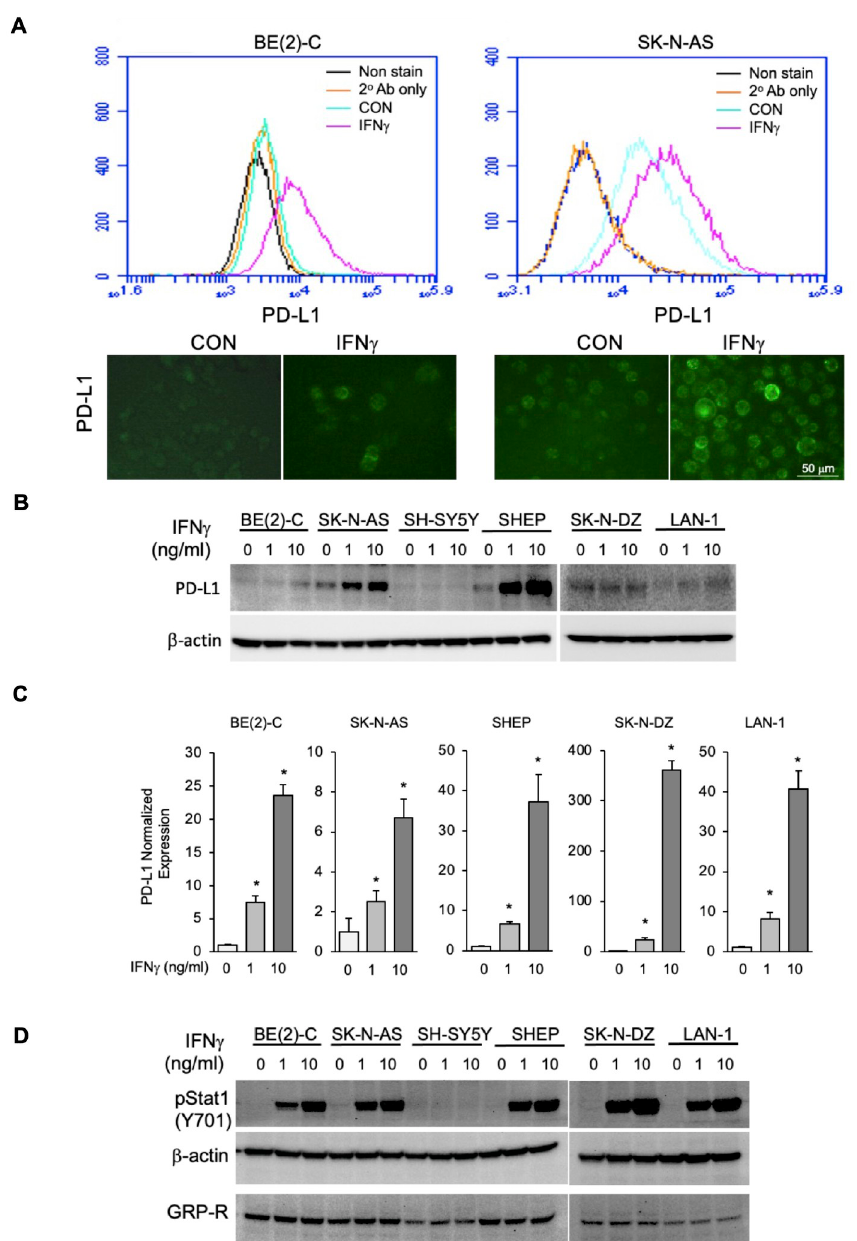
Fig 5. Immune checkpoint protein PD-L1 expression in neuroblastoma cells. (A) PD-L1 expression on the surface of BE(2)-C and SK-N-AS cells was analyzed by flow cytometry (top) and fluorescent microscopy (bottom). Cells were treated with IFN γ (10 ng/ml) for 24 hours. (B) The total expression of PD-L1 was detected in six human neuroblastoma cell lines by immunoblotting analysis. The cells were treated with IFN γ at 0, 1, or 10 ng/ml for 24 hours. Total cell lysates were used in immunoblotting assay. β -actin was used for protein loading control. (C) The mRNA level of PD-L1 was measured by qRT-PCR and normalized to GAPDH in six human neuroblastoma cell lines. All cells were treated with IFN γ at 0, 1, or 10 ng/ml for 24 hours. (D) Phosphorylated Stat1 was measured in six neuroblastoma cell lines. All cells were treated with IFN γ at 0, 1, 10 ng/ml for 24 hours. The levels of phospho-Stat1 and GRP-R were detected with immunoblotting. β -actin was used for protein loading control.